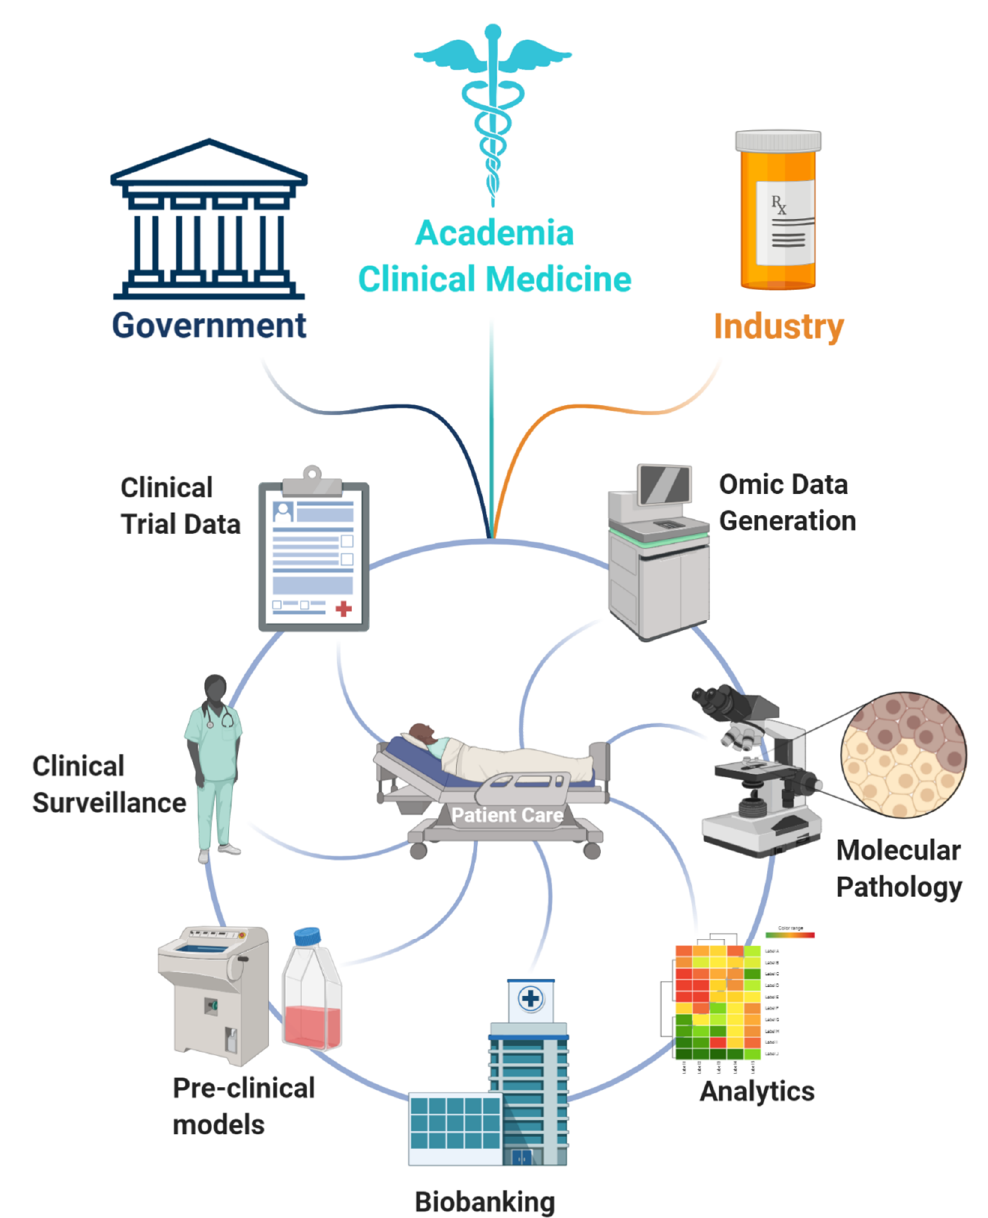
Figure 4. Main stakeholders and players in forward and reverse translation. Translation of activity signatures into clinical practice requires the integration of multiple data types and expertise. These include clinical trial data, clinical surveillance, humanized pre-clinical models, biobanks, integrative and extensive analytics, molecular pathology, and mass omics data generation. These need to be supported by public health bodies, industry shareholders, and academic researchers to achieve a harmonious, streamlined workflow of data integration culminating in multidisciplinary clinical care and personalized medicine. These collaborations are exemplified by programs such as (IMPRESS, Oslo, Norway) [122] and (CONNECT, Norway) and pan European educational drives such as BioS [125]. Created with BioRender.com.